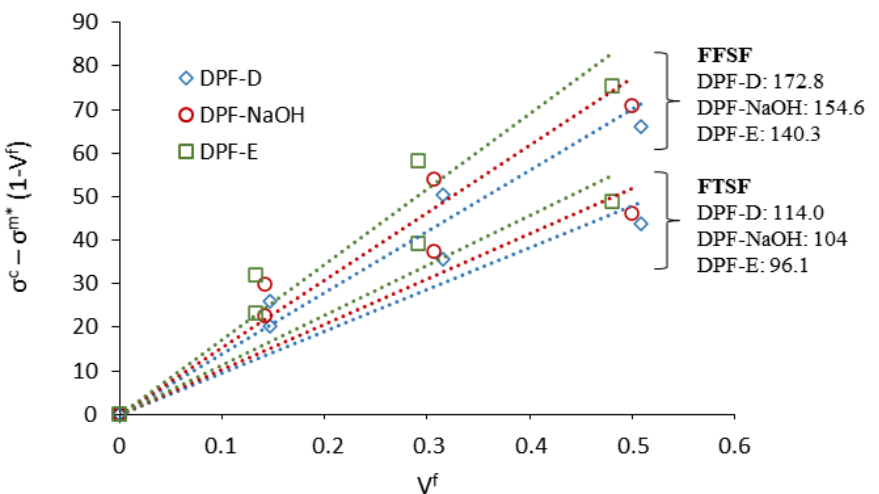
Figure 9. Fiber tensile strength factor and fiber flexural strength factor of date palm fiber composites. ( σ fF ) of DPF-D, DPF-NaOH, and DPF-E as 541 MPa, 607 MPa, and 719 MPa, respectively.